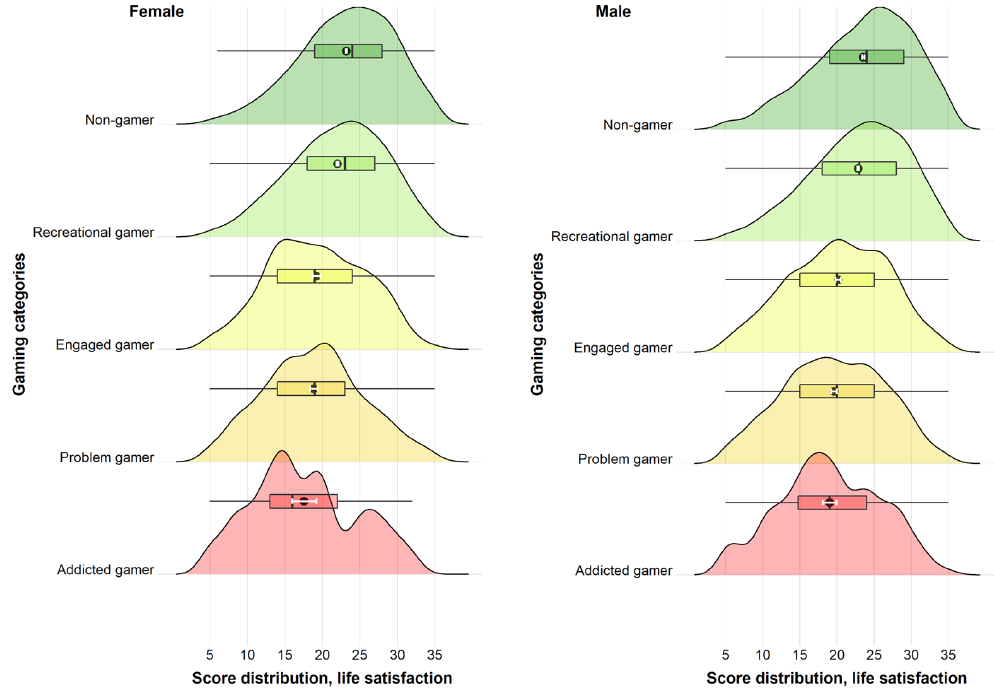
Figure 3. Association between gaming categories and life satisfaction. Ridgeline plots. Density distributions and corresponding boxplots (with outliers truncated). Black dot indicates mean estimate and white horizontal error bar indicates 95% confidence interval of the mean estimate.